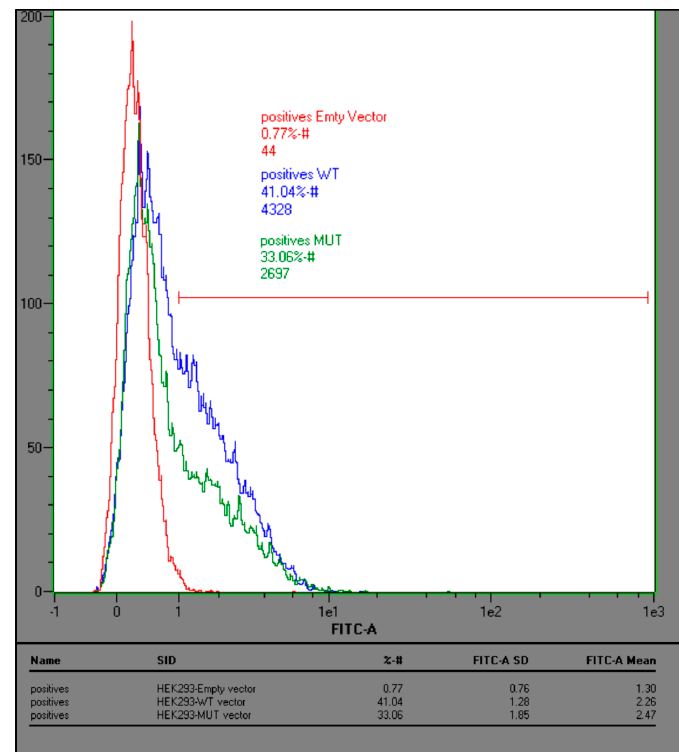
Figure A5. Leu16 to Pro mutation in the signal peptide of IL-22BPi2 is associated with lower intracellular levels. HEK293 cells were transfected with the IL22RA2v2 wild type (Leu16), mutant (16P) or empty expression plasmids; 24 h later cells were fixed, permeabilized and immunostained with anti-IL22BP antibody. Cells were analyzed by flow cytometry.